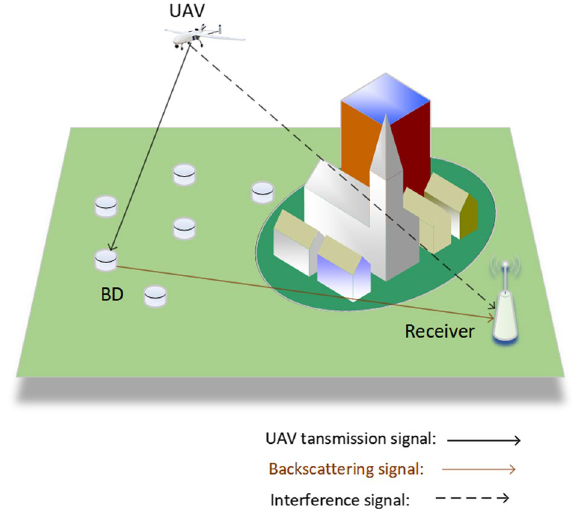
Fig. 1 UAV-assisted backscatter communication